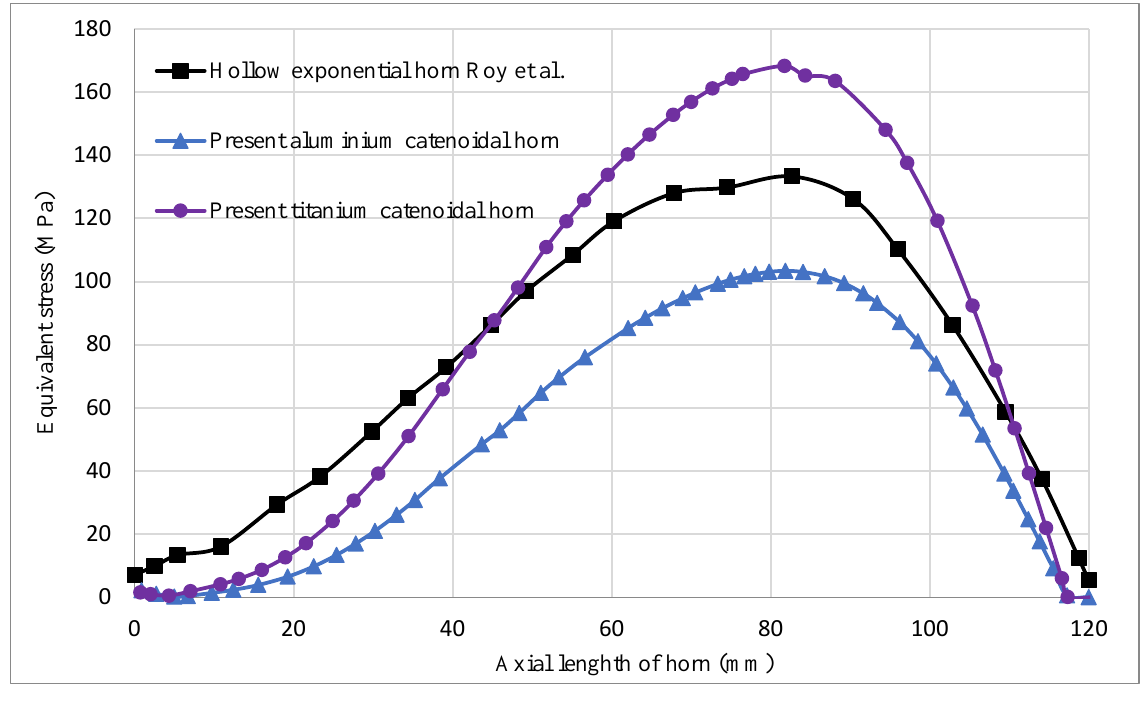
Figure 10. Equivalent stress variation of various